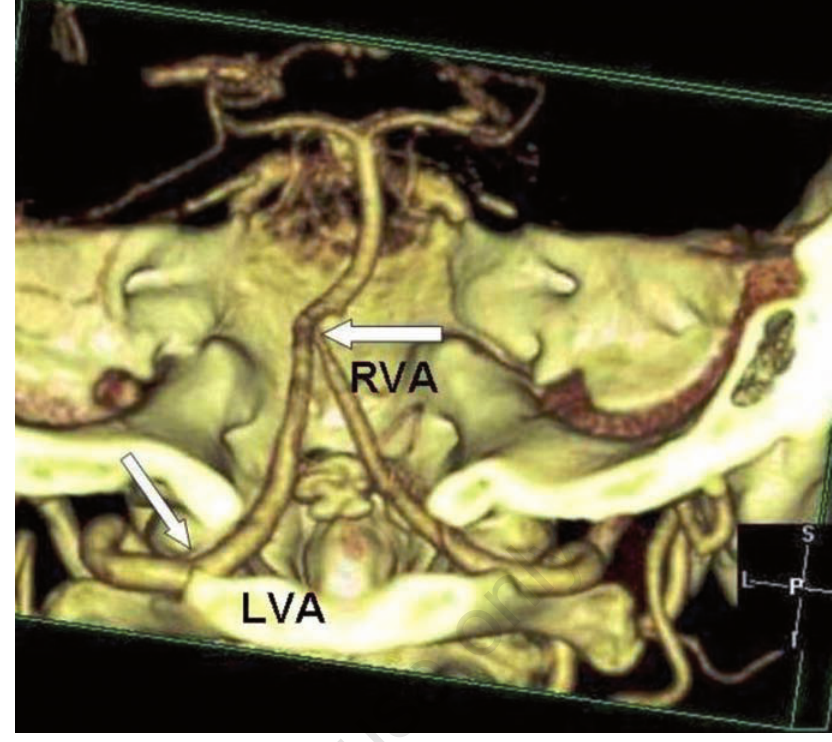
Figure 1. Three-dimensional computed tomographic angiography showing the stenoses (arrows) of the right vertebral artery and left vertebral artery. RVA, right vertebral artery; LVA, left vertebral artery.